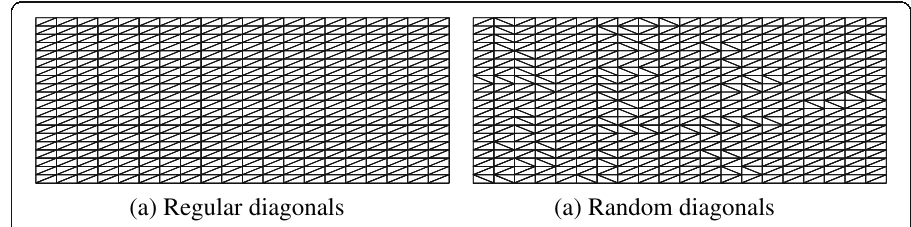
Fig. 32 Quadrilateral grids split by ( a ) regular and ( b ) random